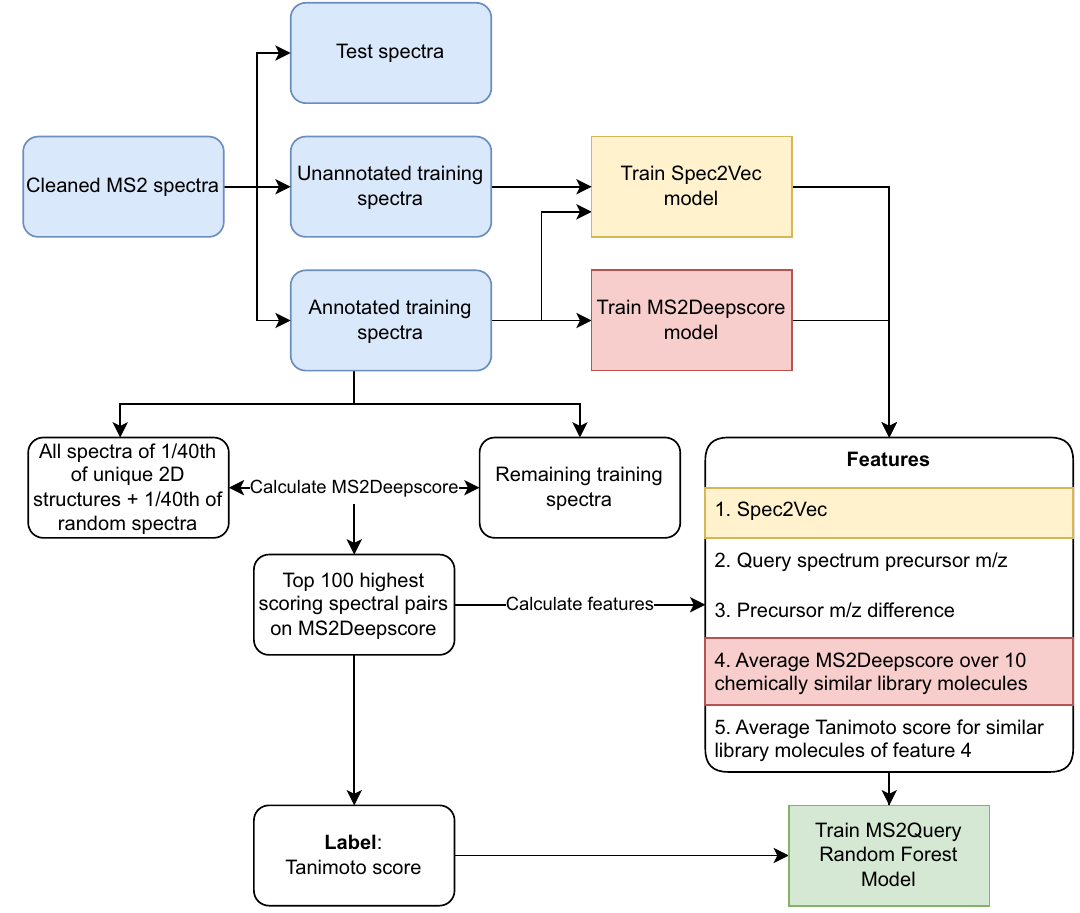
Fig. 5 | Work fl ow for MS2Query model training. Work fl ow for training the MS2Deepscore model,the Spec2Vec modeland the random forest model used by MS2Query. Rounded boxes indicate mass spectral handling steps, whereas squared boxes are indicating machine learning model training steps. The blue